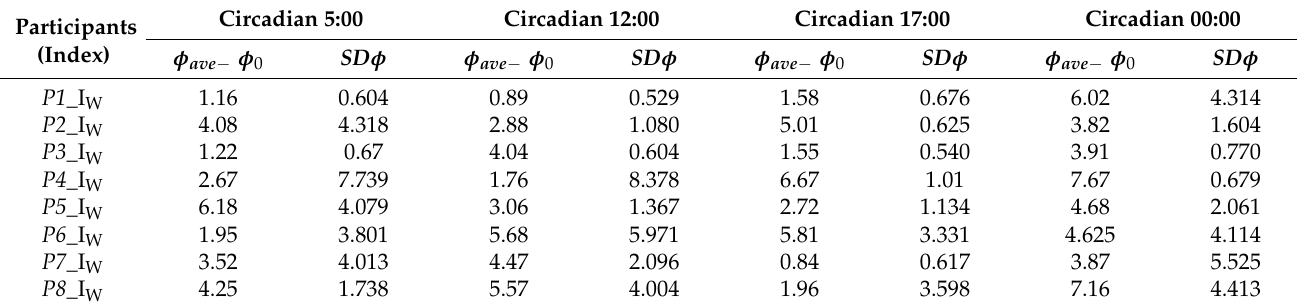
Table 2. Raw values for Experiment 1.